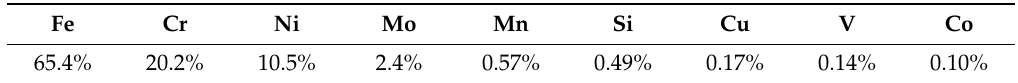
Table 1. Steel fiber chemical composition.